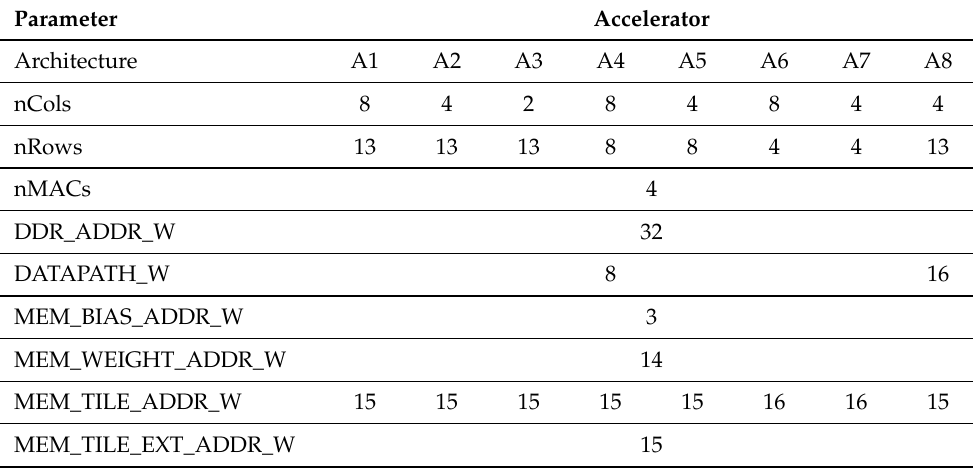
Table 7. Configuration parameters for the accelerator.